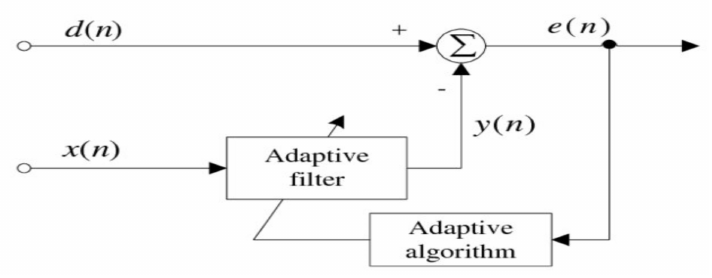
Figure 3. General block diagram of an adaptive